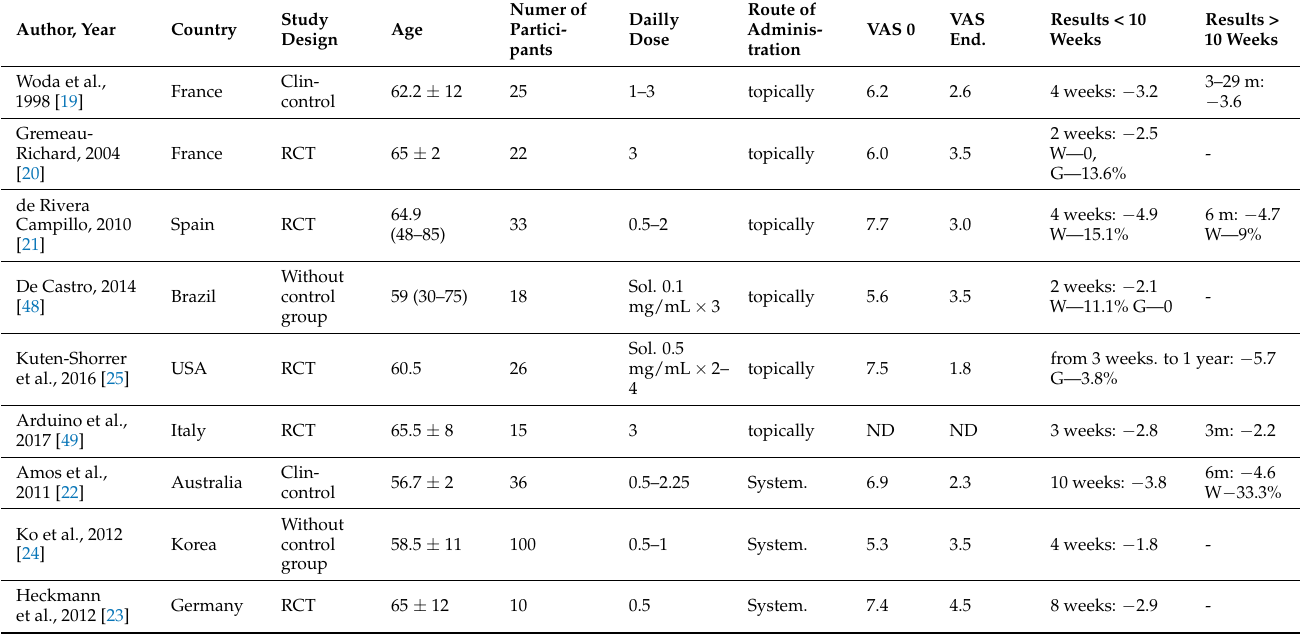
Table 5. Clinical outcomes of pain intensity reduction in BMS after